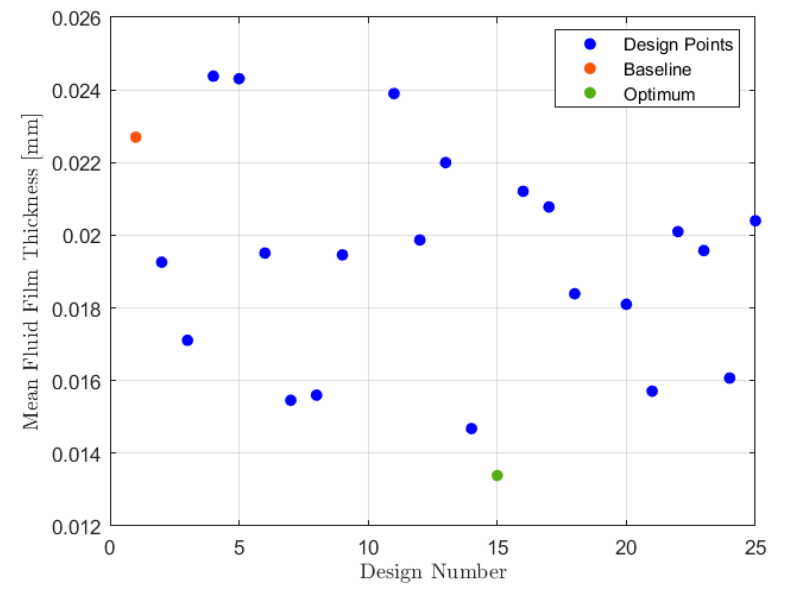
Figure 11. Solution of the Volvo mirror optimization.